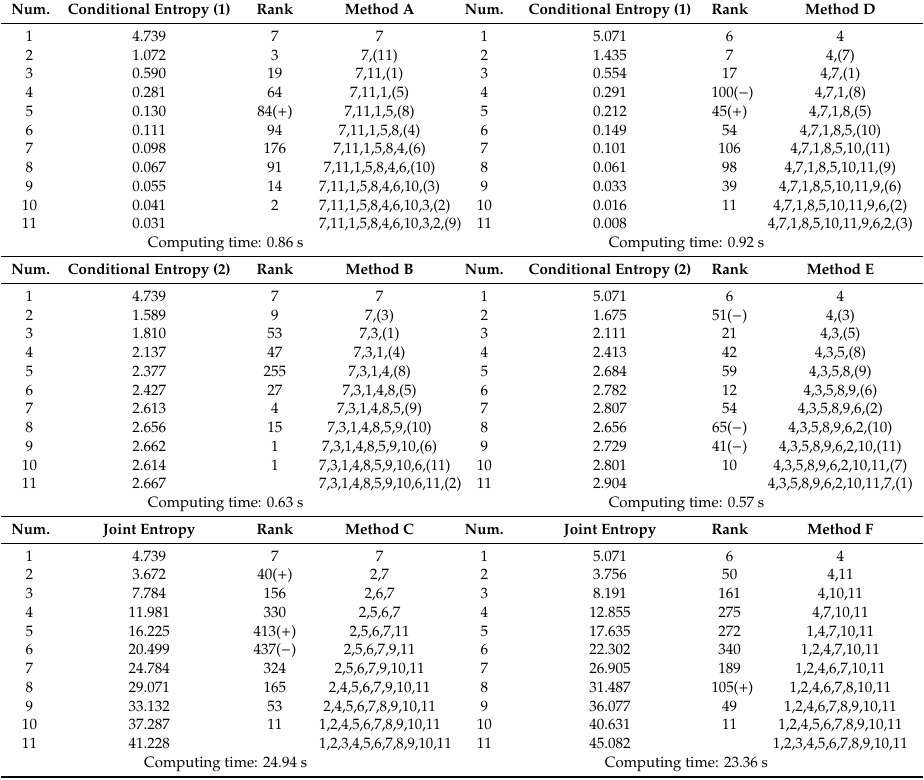
Table A4. Results of a select optimal rain gauge network of methods (weight: monthly average precipitation). Num. Conditional Entropy (1)